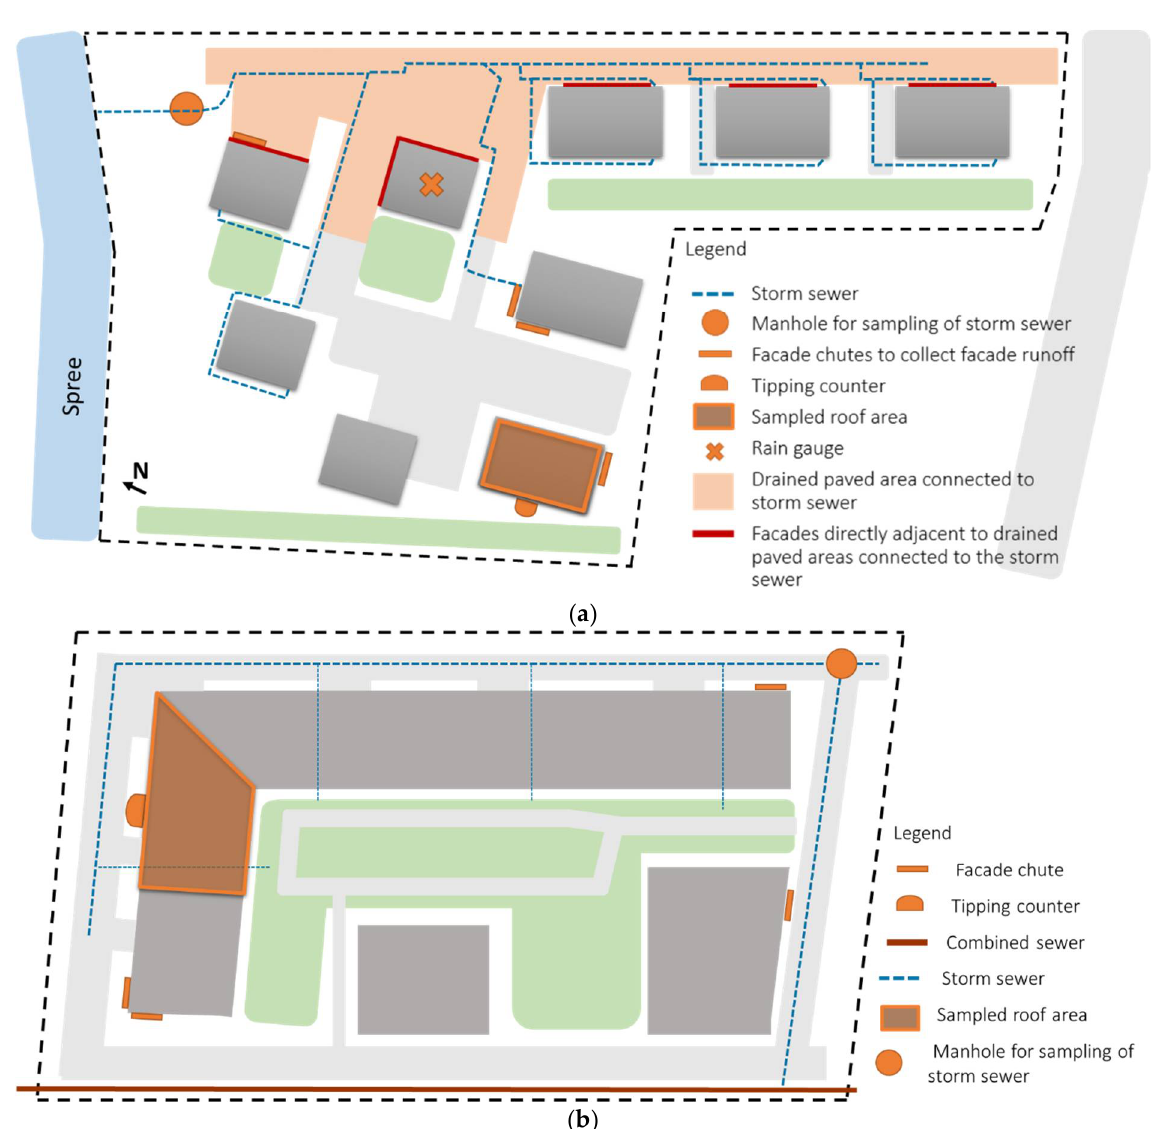
Figure A1. Schematic view of test site A ( a ) and test site B ( b ).